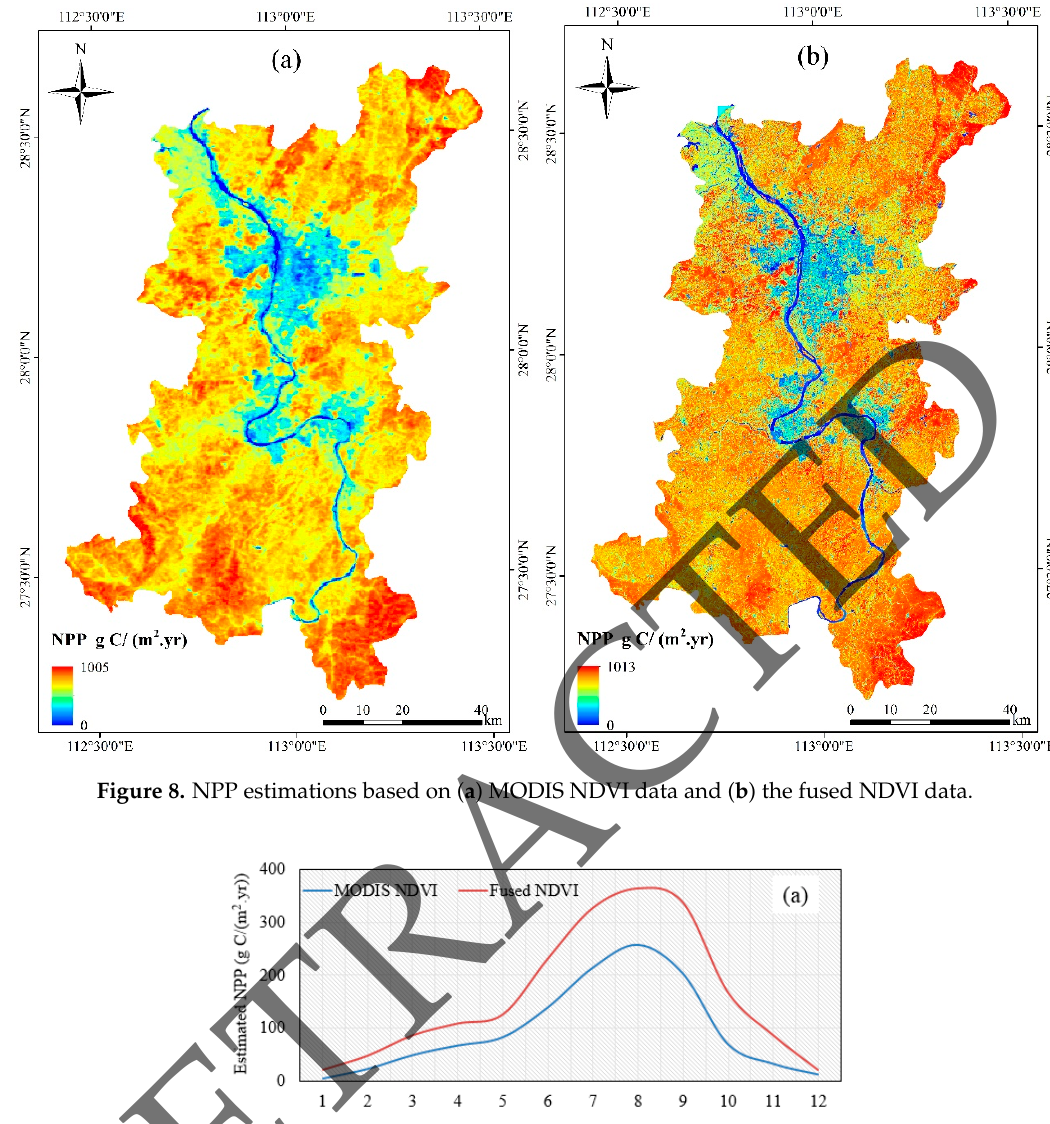
Figure 9. Estimated NPP results under vegetation coverage ( a ) <20% and ( b )